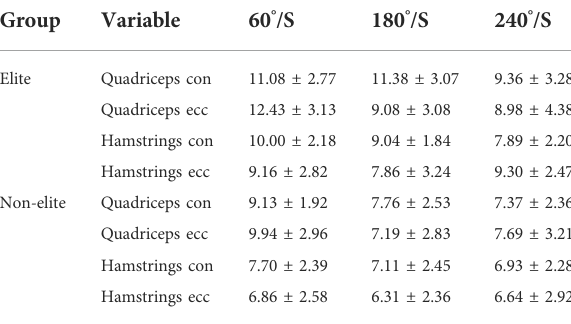
TABLE 4 Bilateral ratios (%) in extensor and fl exor by the performance group.